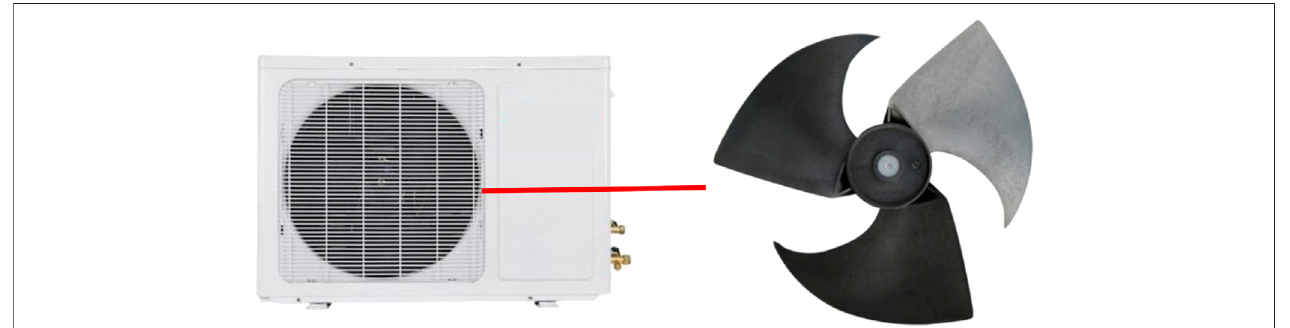
FIGURE 1 | Axial fl ow fan model.